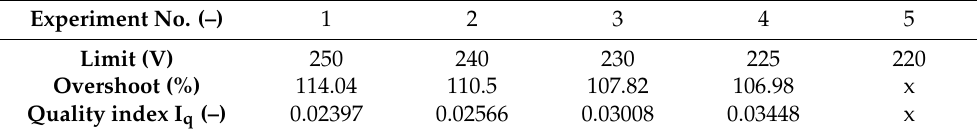
Table 8. Parameters values of control system with voltage limits for two-input